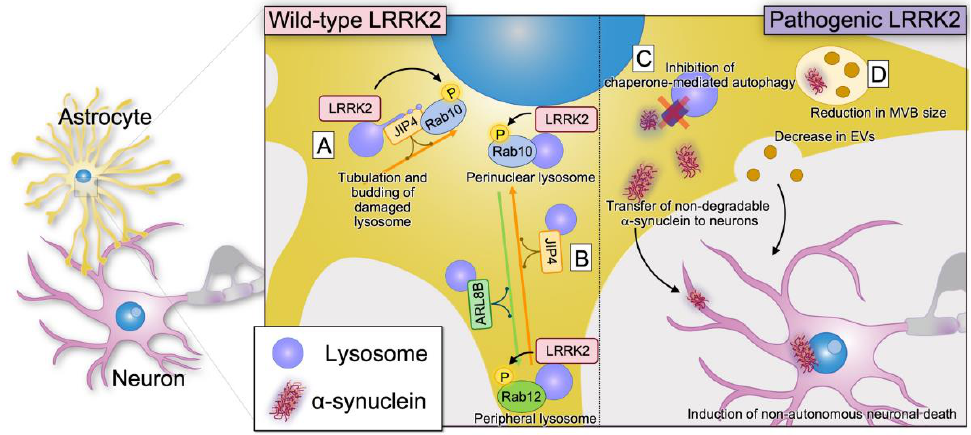
Figure 3. Reported roles of LRRK2 in astrocytes. ( A ) LRRK2 accumulates in membrane-damaged lysosomes and phosphorylates downstream Rab10, causing lysosomal tubulation and budding